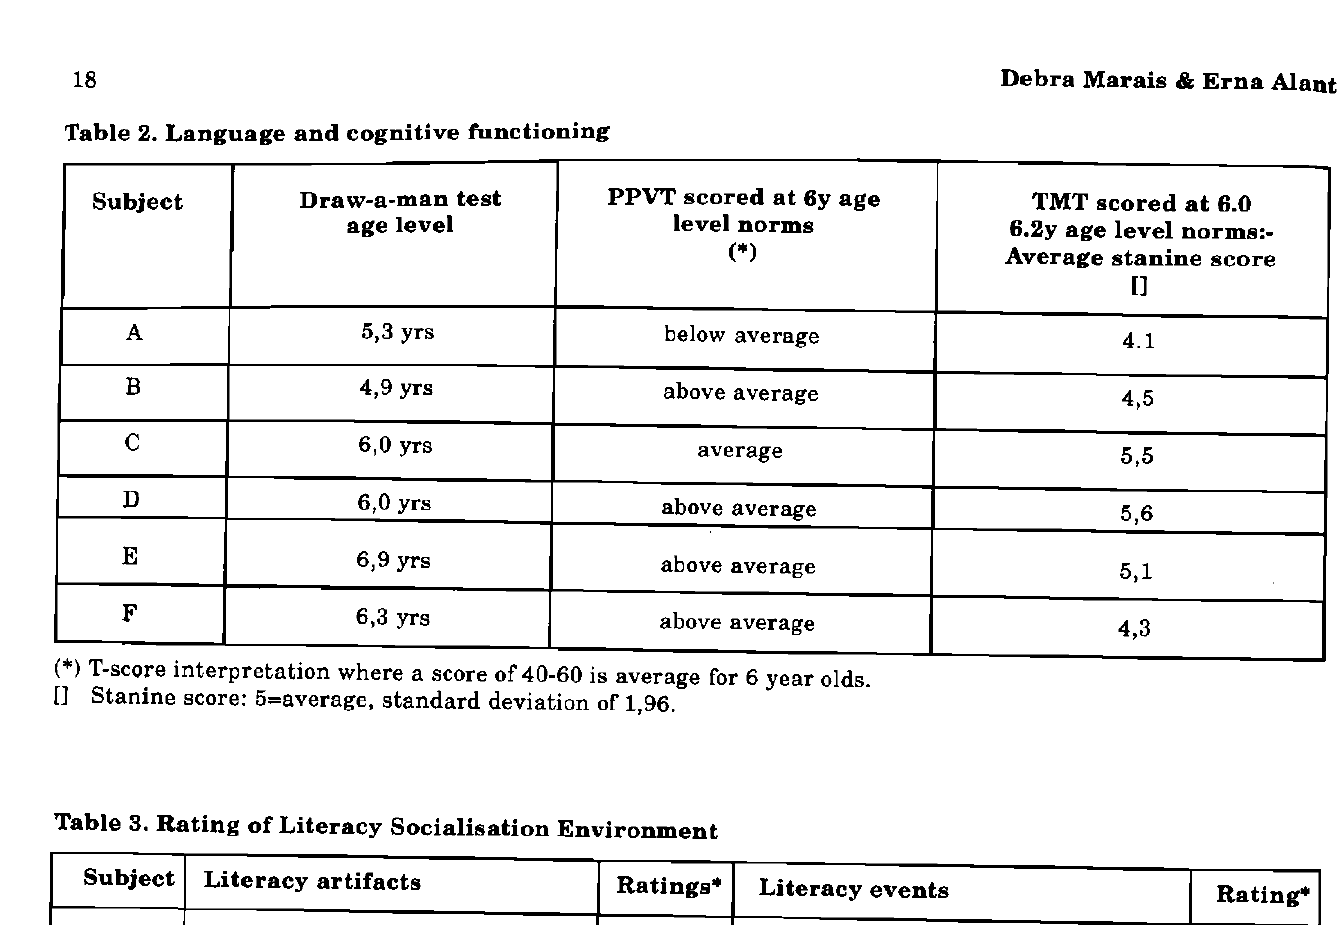
Table 3. Rating of Literacy Socialisation